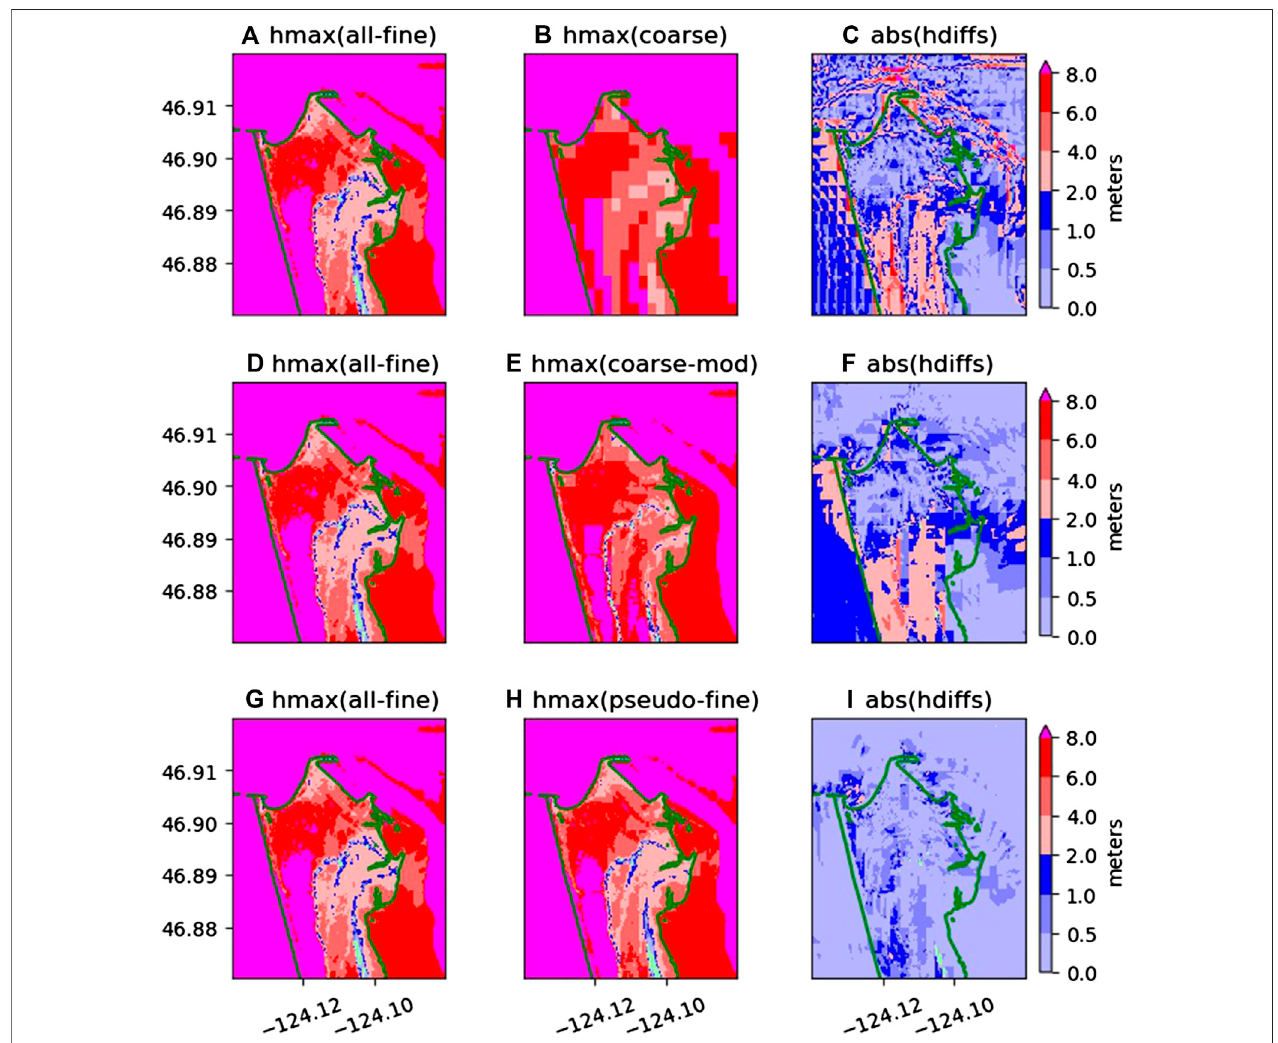
FIGURE7| Sampleresults forrealization 1,999at Westport,where thetsunami waslarge.Panels asdescribed in Figure 5 .Purple isabove8 mand Greenisland not inundated.